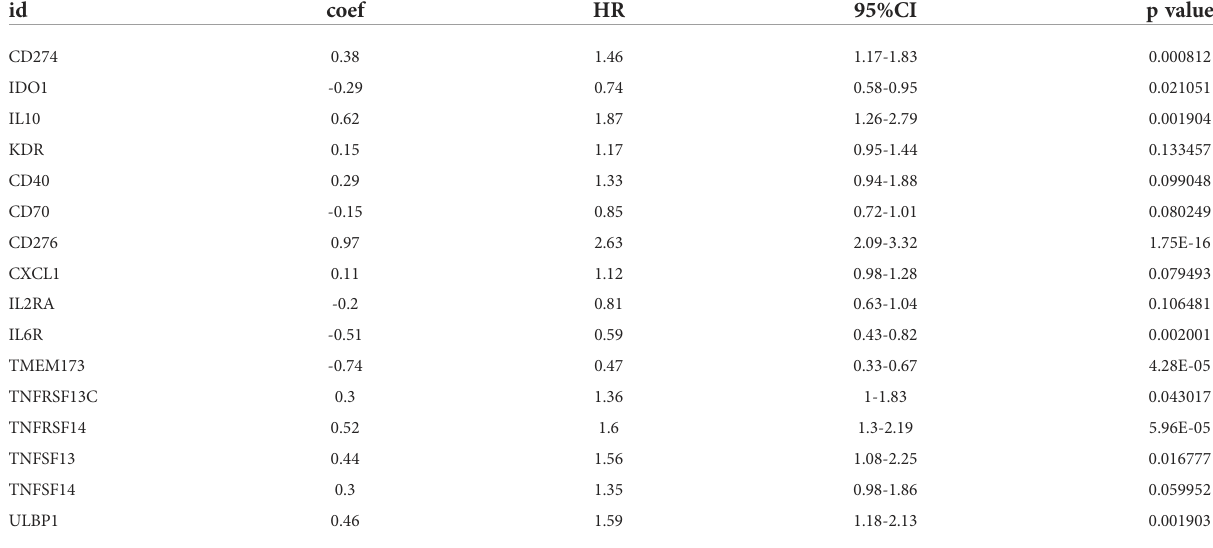
TABLE 4 COL6A2 related prognostic immunomodulator